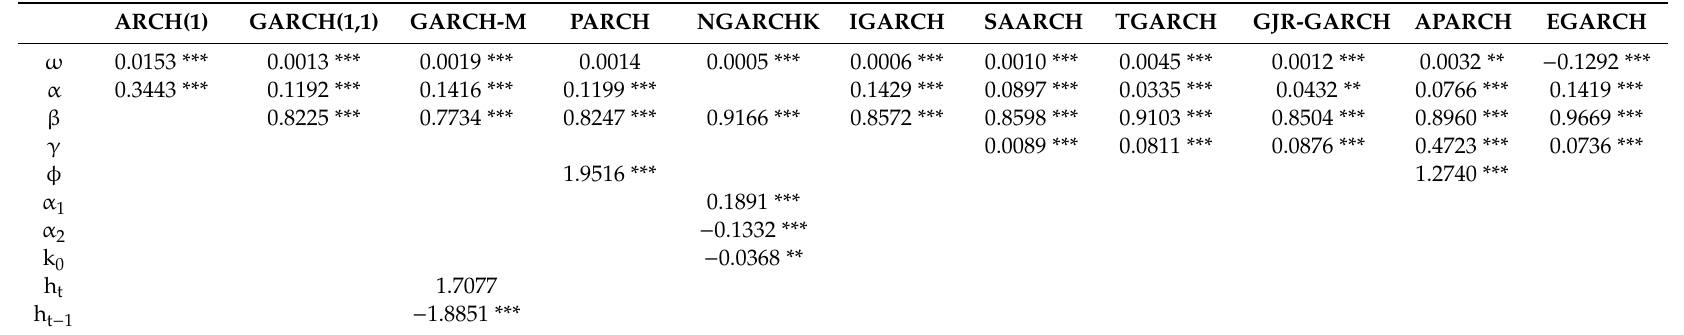
Table 3. GARCH estimations and diagnostic tests for electricity prices. *** and ** denote significance at the 1% level and 5% level, respectively.